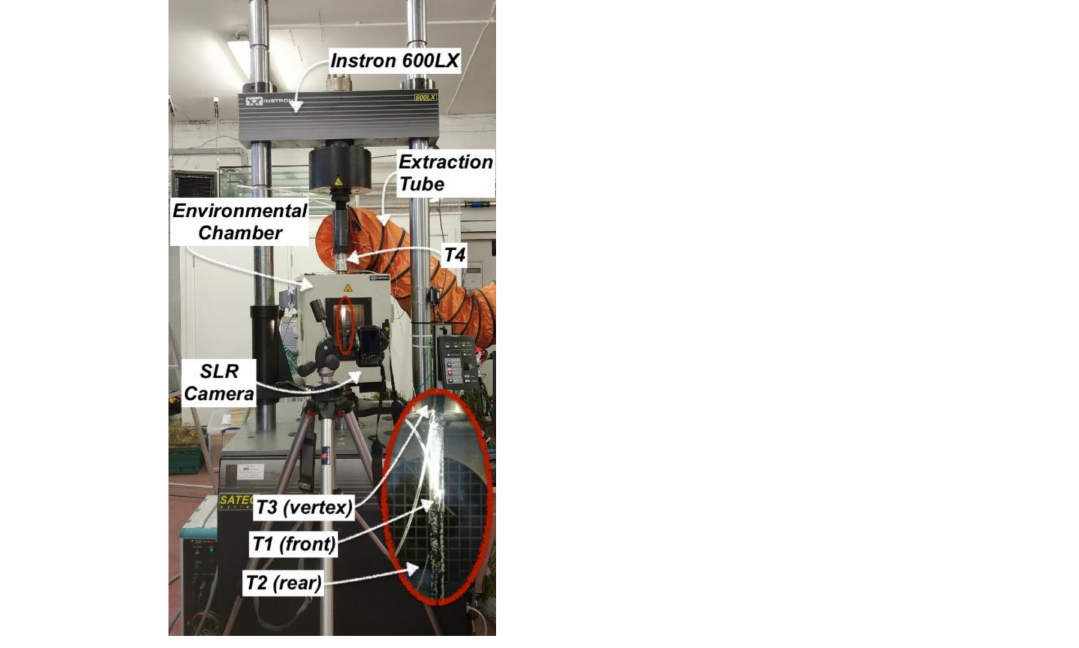
Figure 11. Test set-up for SS tests, with details of thermocouples’ position in the chamber (bot- tom right).